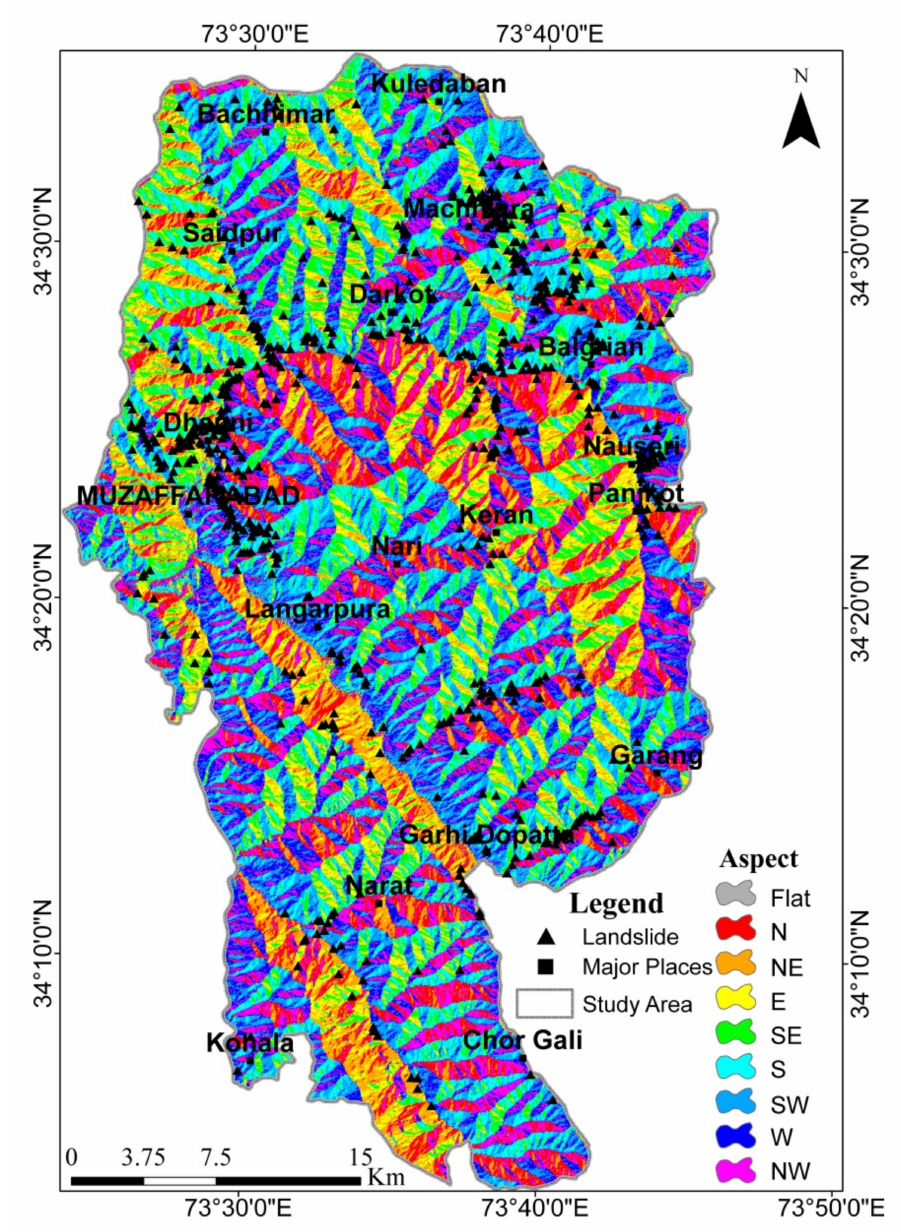
Figure 6. Aspect causative factor